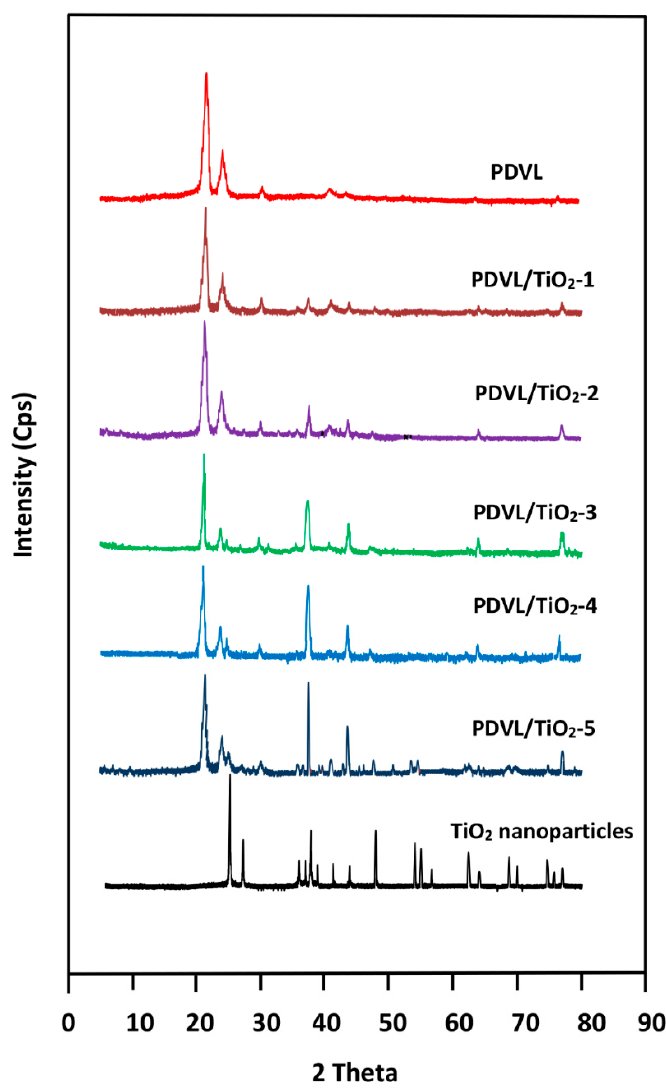
Figure 1. XRD refractograms of TiO 2 nanoparticles, pure PDVL, and their nanocomposites containing different TiO 2 contents.